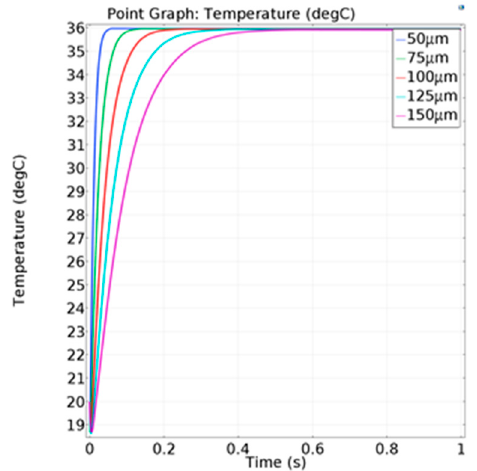
Figure 4. The temperature variation of the film center under different film thicknesses. Thirdly, the distribution of the cold and hot junctions was simulated. The heat-transfer efficiency of the polyimide film along the thickness was larger because its thickness was far less than the length and width. As a result, the center temperature of the film increased with the skin temperature. As shown in Figure 5, two isosceles-square parts of the thin film were less effected by the skin because they were suspended and separated from the skin in the nostril. The cold conjunctions were located on the two isosceles-square parts to keep them at a constant temperature.